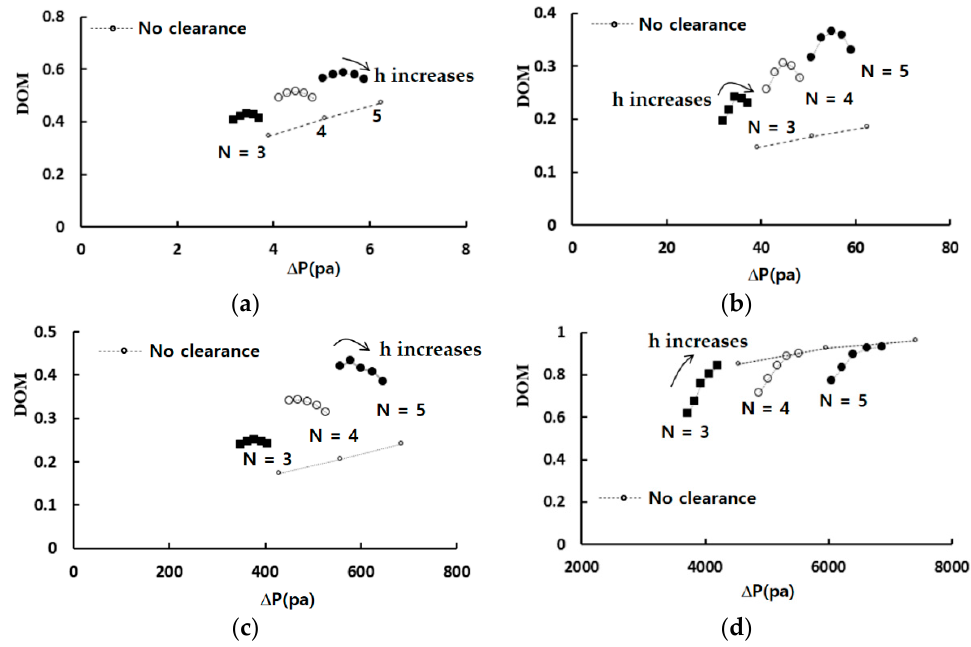
Figure 7. Mixing performance map: ( a ) Re = 0.1, ( b ) Re = 1, ( c ) Re = 10, and ( d ) Re = 50.